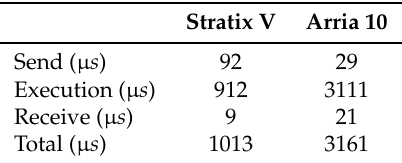
Table 1. Results for the Jacobi method.